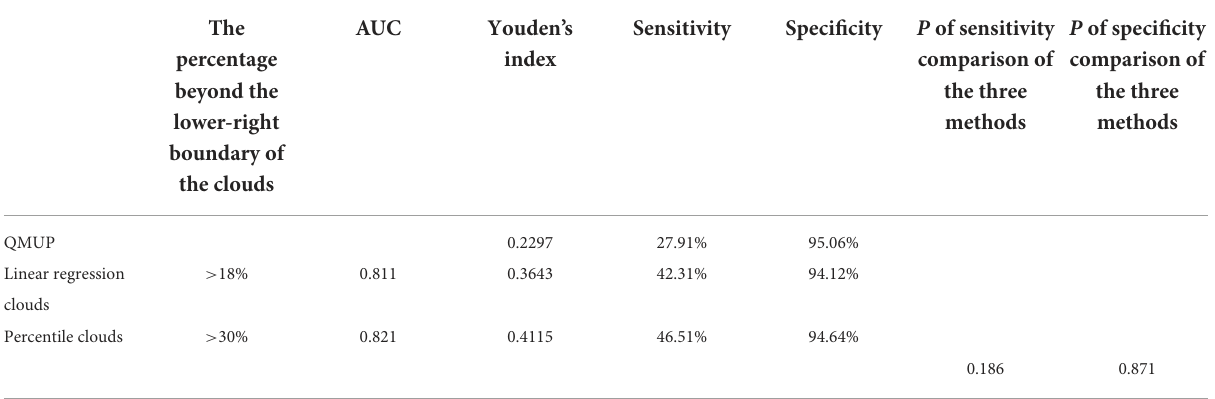
TABLE 10 The sensitivity and specificity of each method for discrimination of myopathic vs. non-myopathic lesion muscles.